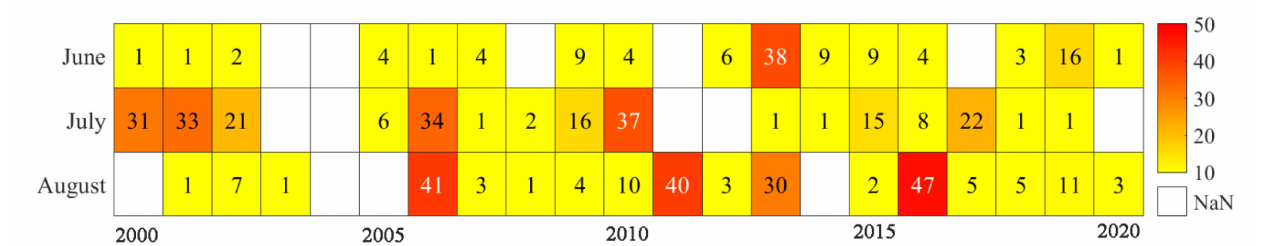
Figure 4. Matrix heatmap of the number of sites with heatwaves from June to August on the Tibetan Plateau from 2000 to 2020. Each grid cell represents the number of sites with heatwaves in a given month of a year. The blank grid represents no heatwave, and the value is NaN. The color of the matrix heatmap represents the size of the